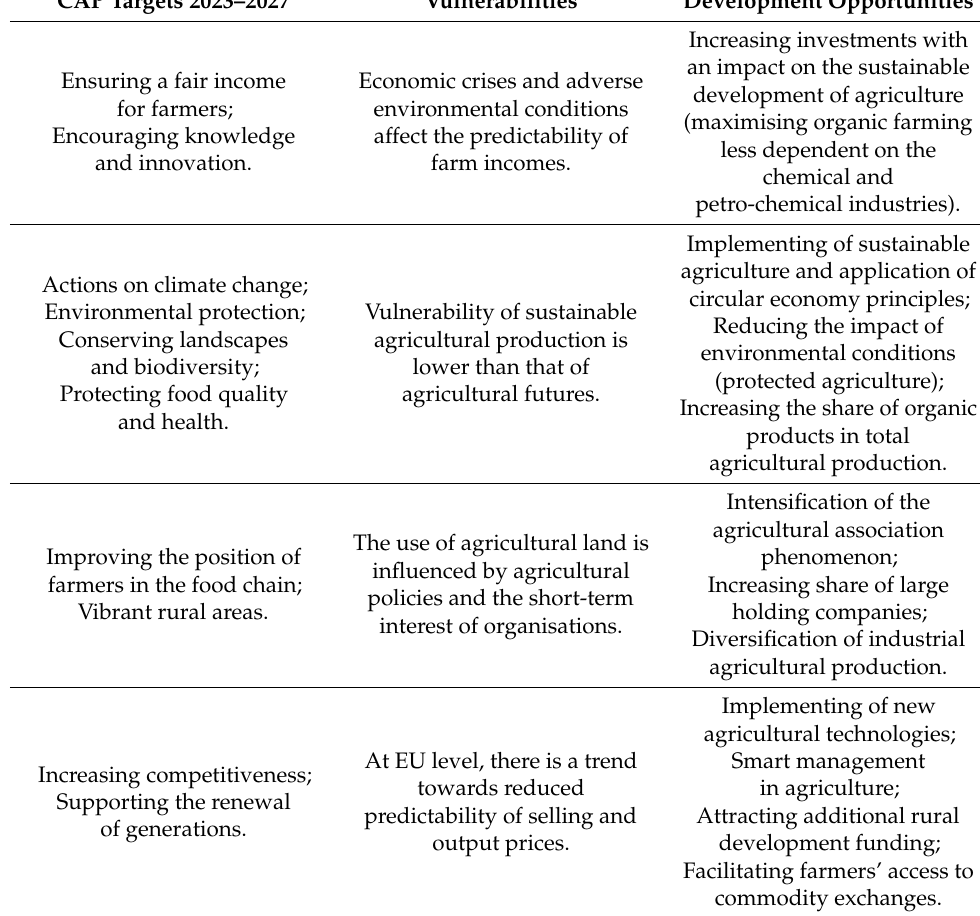
Table 12. Scoreboard of viable agricultural development